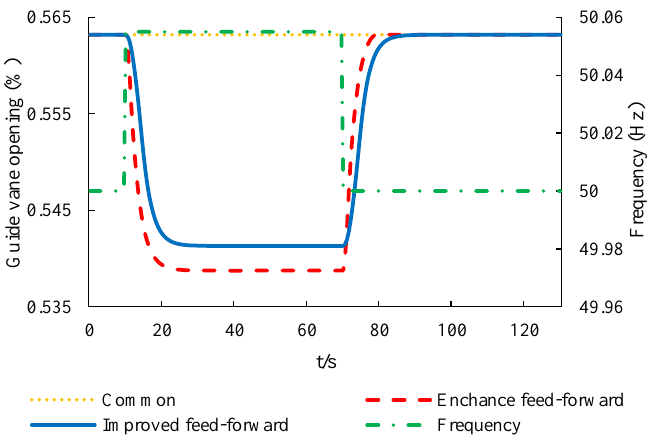
Figure 17. The guide vane opening curve of PFC with common frequency dead zone, enhanced frequency dead zone with feed-forward control, and improved frequency dead zone with feed-forward control.